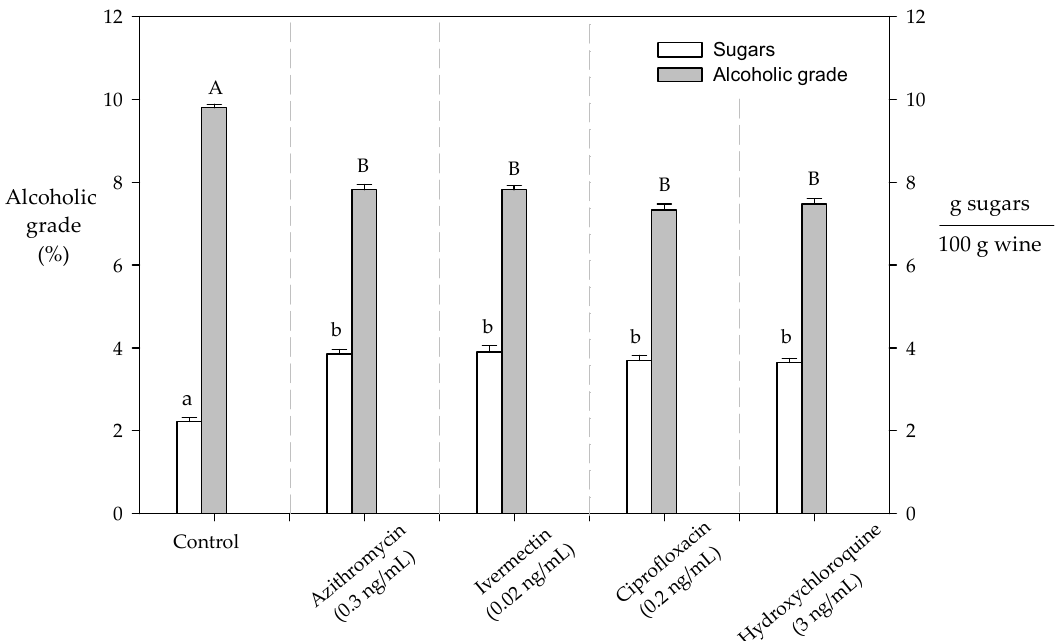
Figure 6. Alcoholic degrees at the end of the fermentation process. The significant differences ( p < 0.05) are established with different lower-case letters and capital letters for the sugar content and alcoholic grade, respectively.